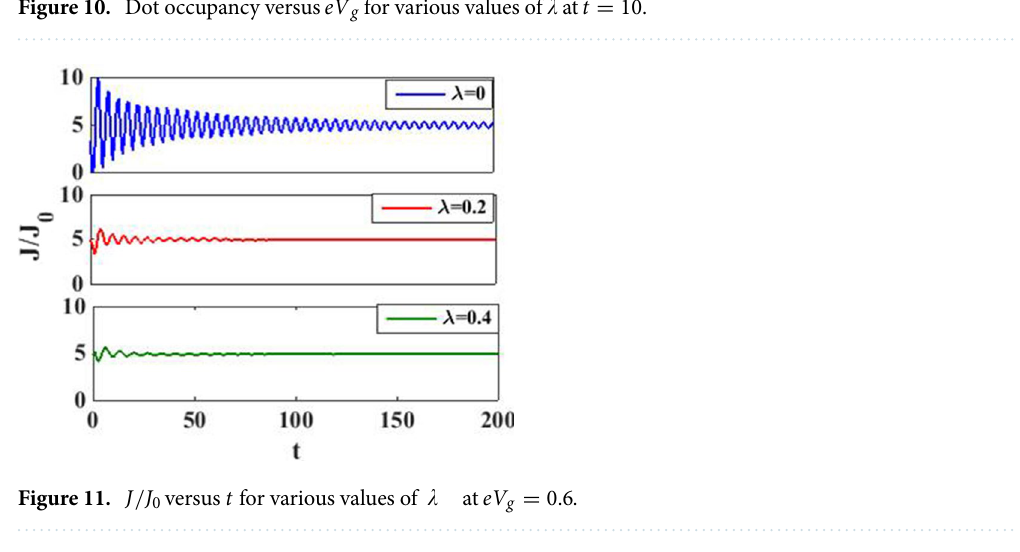
Figure 10. Dot occupancy versus eV g for various values of (cid:31) at t = 10.